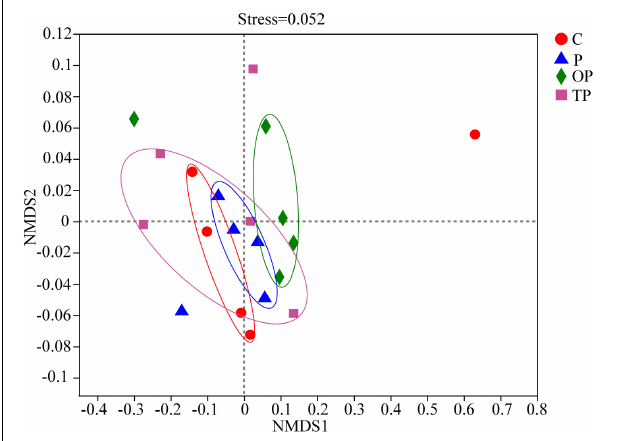
FIGURE 4 | UniFrac distance-based Nonmetric Multidimensional Scaling (NMDS) analysis of intestinal microbial communities of sea cucumber fed diet supplementation with different levels of PHB. C (control): basal diet; P: basal diet supplementation with 0.5% PHB; OP: basal diet supplementation with 1% PHB; TP: basal diet supplementation with 3%